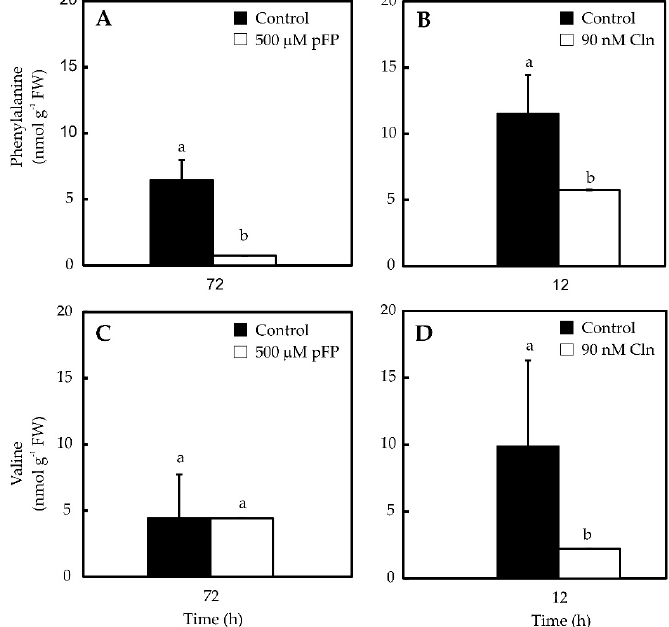
Figure 4. Phe ( A and B ) and Val ( C and D ) contents in placentas exposed to p-FP ( A and C ) and Cln ( B and D ). Data represent mean ± standard deviation (S.D.) of three independent experiments with three replicates. Bars labeled with different letters are significantly different (Tukey’s test, α = 0.05).